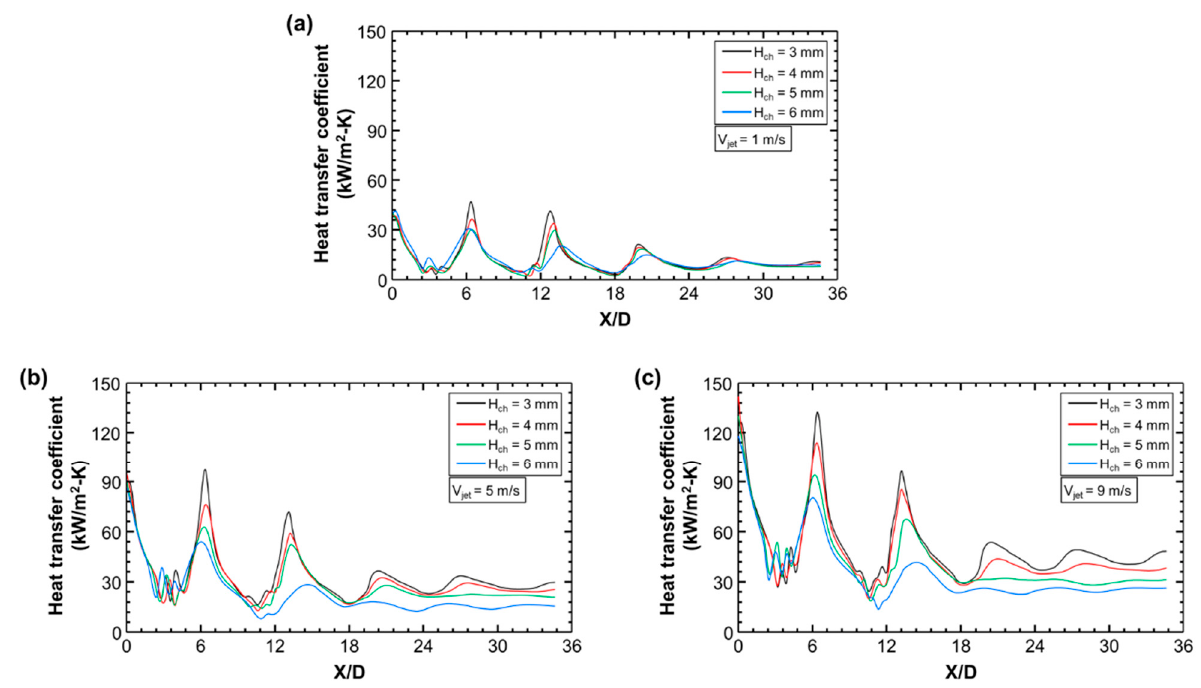
Figure 12. Spanwise averaged heat transfer coefficient distributions at target surface at ( a ) V jet = 1 m/s; ( b ) V jet = 5 m/s; ( c ) V jet = 9 m/s.